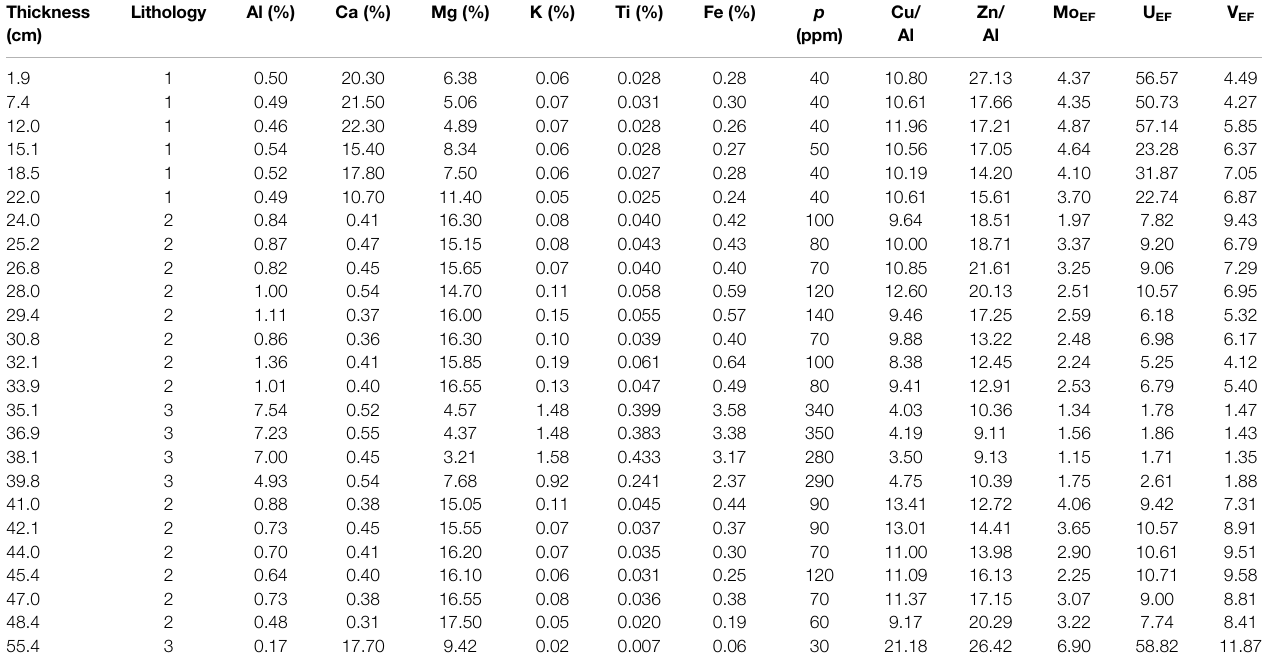
TABLE 2 | Contents and ratios of representative elements in the fi ve layers in the Lengshuixi section. Thickness (cm)